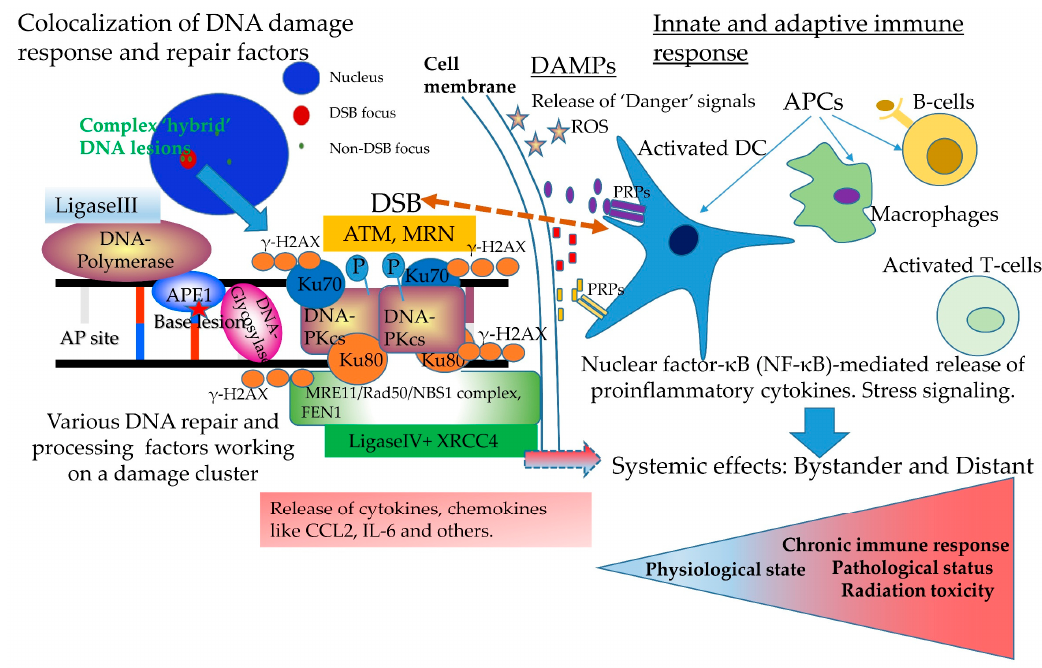
Figure 2. Linking processing of clustered DNA damage and immune response. I. The challenge of repairing a clustered damaged DNA site: a task for real survivors. Upon the induction of clustered DNA damage consisting for example of one double strand break (DSB) and two oxidative DNA lesions like a damaged base (shown here with an asterisk) and an apurinic/apyrimidinic (AP) site, two at least DNA repair pathways and several DNA repair proteins will arrive at the same chromosome region. For the base damage, the primary pathway is the base excision repair (BER) while for the DSB, here we consider for simplicity only the non-homologous end joining (NHEJ). In all cases, the most basic proteins and enzymes are also described in the main text. Last but not least, as shown by advanced fluorescence microscopy and foci colocalization, each DSB is expected to be rapidly accompanied by the phosphorylation of thousands of H2AX histone protein molecules called γ H2AX. The MRN complex functions rather as a sensor of DNA ends and activates ATM kinase. The ATM phosphorylates substrates such as Chk2, p53, and the H2AX in flanking chromosomal regions. II. Linkage to immune response. Processing of clustered DNA damage and especially of unrepaired orpersistent is expected to lead to senescence or cell death i.e., apoptosis, necrosis (accidental, non-programmed), and necroptosis (programmed). All these processes can trigger the extracellular release of diverse signatures of ‘Danger’ signals or Damage-Associated Molecular Patterns (DAMPs: ATP, short DNAs/RNAs, ROS, heat shock proteins (HSPs), high-mobility group box 1 (HMGB)-1, S100 proteins and others) [65]. DAMPs activate different pattern recognition receptors (PRPs) including for example Toll-like receptors (TLRs) and inflammasomes, a process that leads usually to inflammation and immune-related pathologies. Interestingly, recent evidence as explained in the main text, suggests a direct interactions between different PRPs and DNA repair proteins involved in DSB repair and others (Dashed arrow connecting DSB to PRPs). Cellular damage or death can also lead to the release of several cytokines and chemokines that can regulate immune responses. Activation of PRPs usually results in nuclear factor- κ B (NF- κ B)-mediated release of various proinflammatory cytokines like IL-6, IL-8 and others. The activation of antigen-presenting cells (APCs) like dendritic cells, macrophages will induce primarily the innate immune response (activation of T-cells) and most rarely by B-cells, the adaptive immune response. In all cases, the constituent and constant triggering of the immune system is expected to generate a variety of systemic effects on the organism and possibly pathophysiology, close to the damaged cells often called as “bystander” effects or distant. Overall, for the final assessment of radiation effects and the return to the physiological state, the role of immune response and the systemic nature of radiation is of enormous